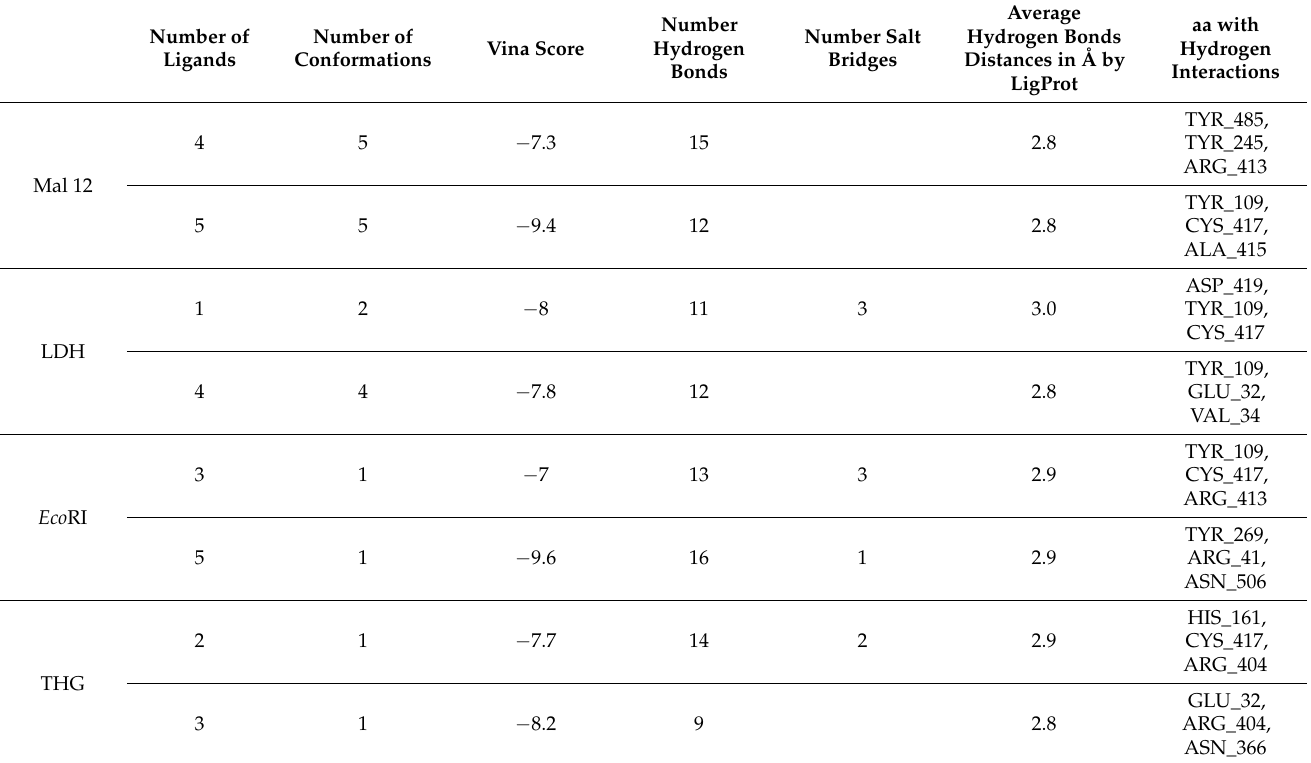
Table 1. Conformation of